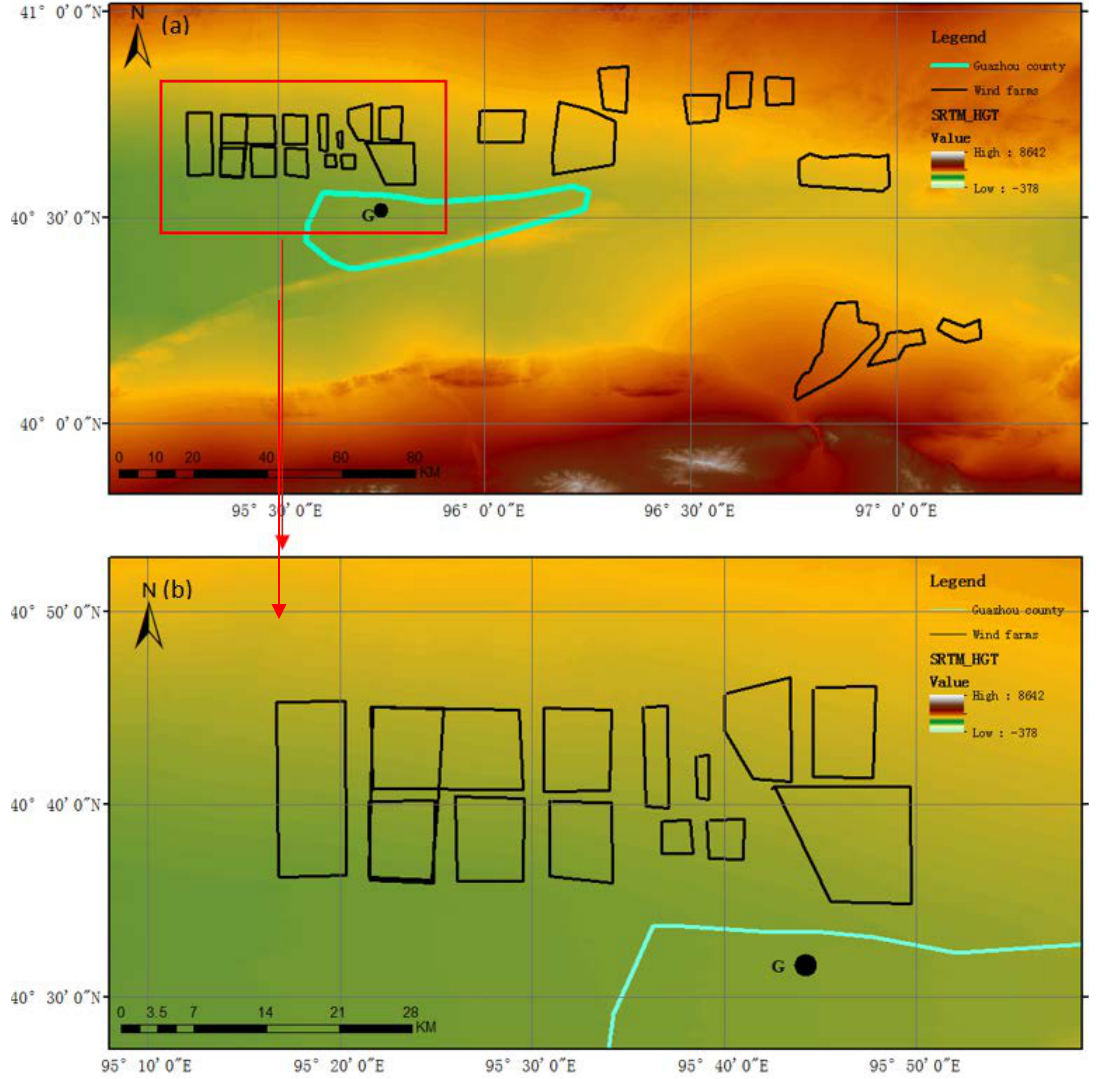
Figure 1. SRTM Elevation map of the study area and its surrounding areas. The surrounding areas (39.5–41.3°N, 95–98.5°E) corresponds to frame ( a ); and the study area (40.38–40.86°N, 95.08–95.88°E) corresponds to frame ( b ). The existence of these wind farm boundaries by the end of 2010 is verified through Google Earth, where each turbine is visible: the wind farm boundaries are marked by the black lines and the center of Guazhou county is framed by the cyan line.